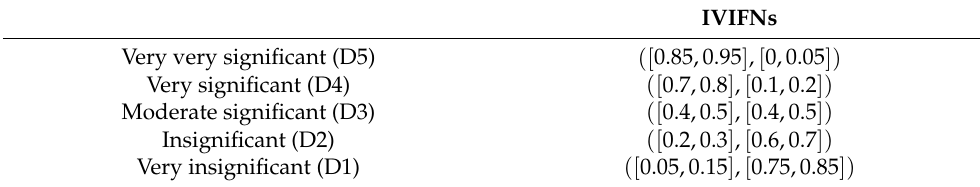
Table 2. The relative importance of decision-makers.